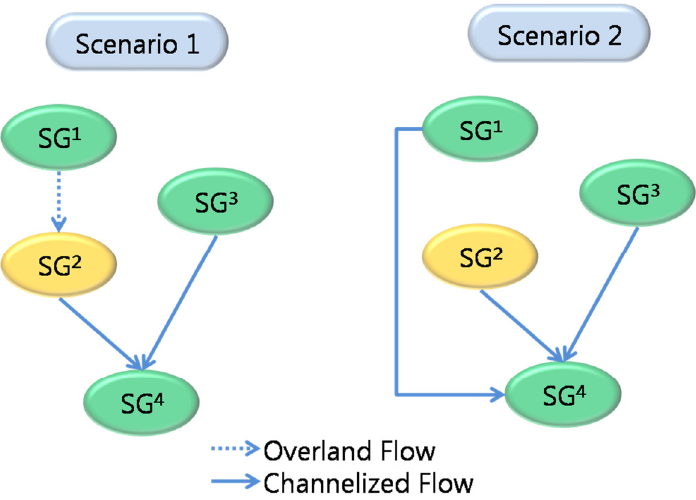
13. Watershed Configuration for Diversion Channel Simulation with Enhanced